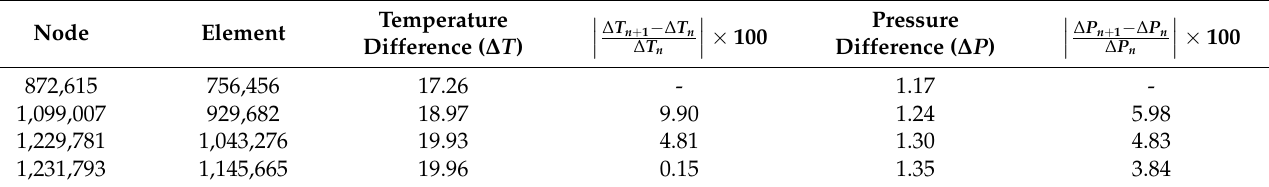
Table 2. Grid details of grid independence